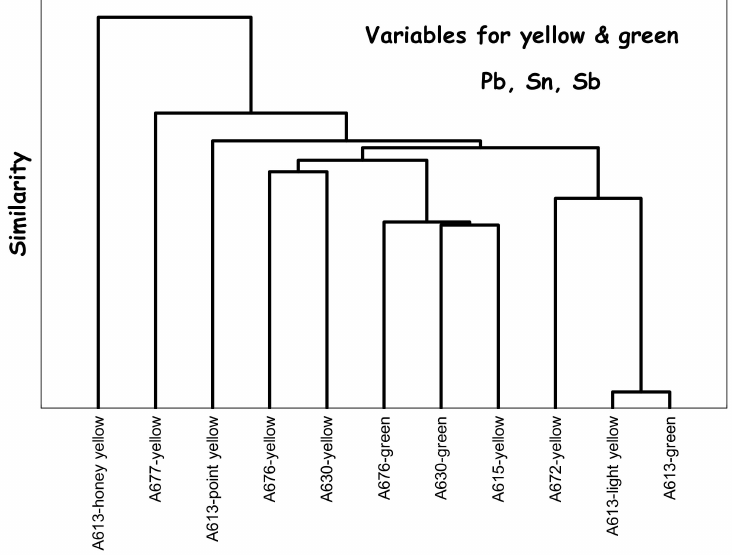
Figure 16. Euclidian dendrogram drawn for yellow and green